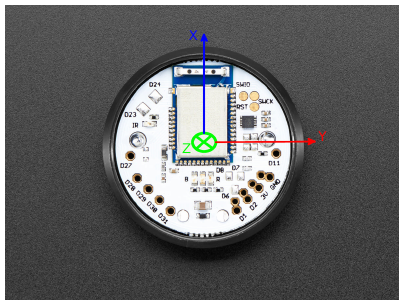
Figure 8. IMU sensor used for this work with its respective